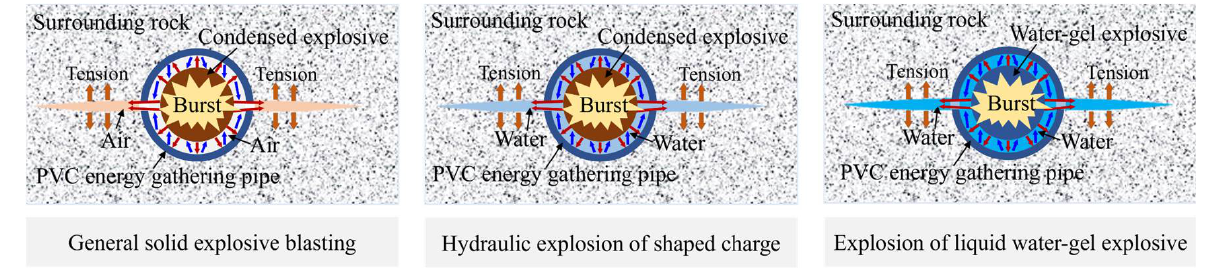
Figure 5. Charge structures of different blasting methods.